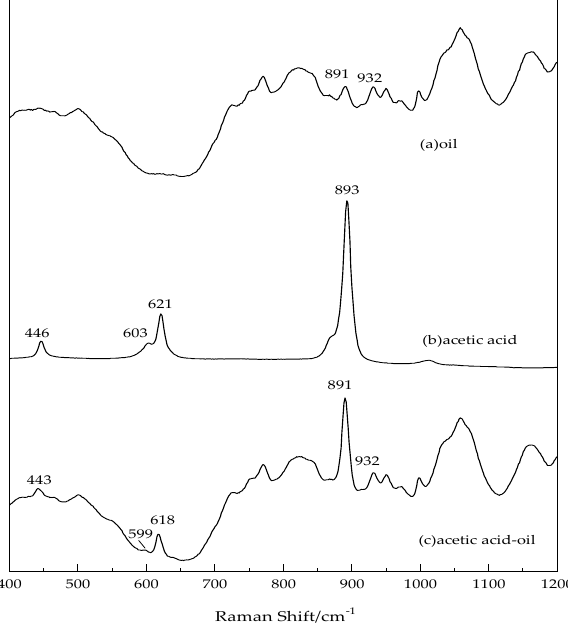
Figure 4. Raman spectra of oil ( a ), acetic acid ( b ), and oil with 40 mg/mL acetic acid concentration ( c ).